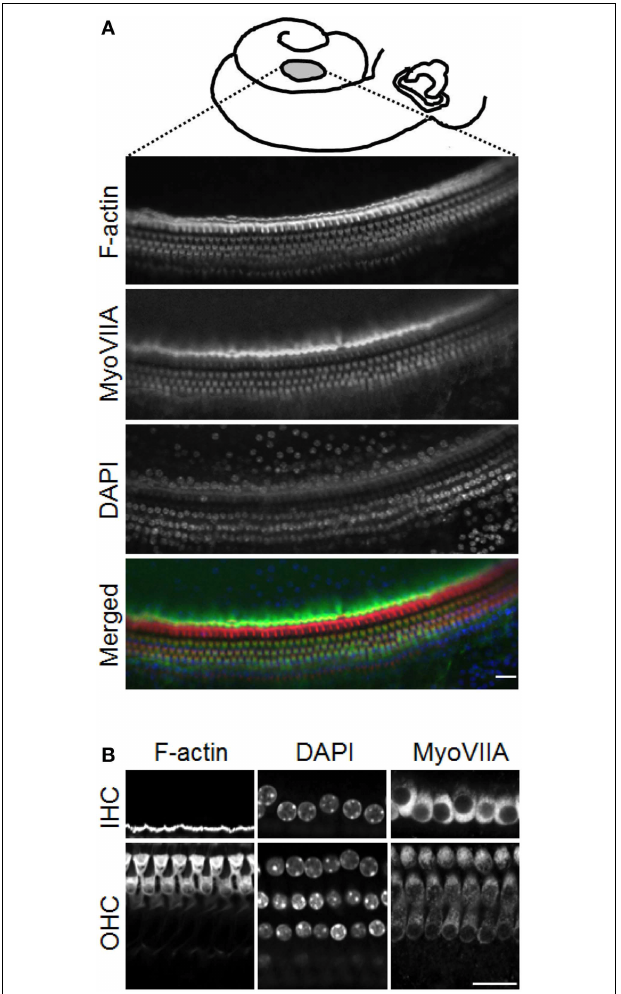
FIGURE 1 | Hair cell status in the ex vivo auditory bulla preparation. (A) Schematic diagram showing the position of the opening made in the mid to apical turn of the mouse cochlea. Lower planes, confocal optical slices showing inner and outer hair cells labeled with phalloidin (for F-actin, red), DAPI (nuclei, blue) and immunolabeled for myosin VIIA (MyoVIIA, green), and a color merge of the different channels. (B) Higher magnification images of inner (IHC) and outer hair cells (OHC). Scale bars: (A) 20 µ m, (B) 20 µ m.